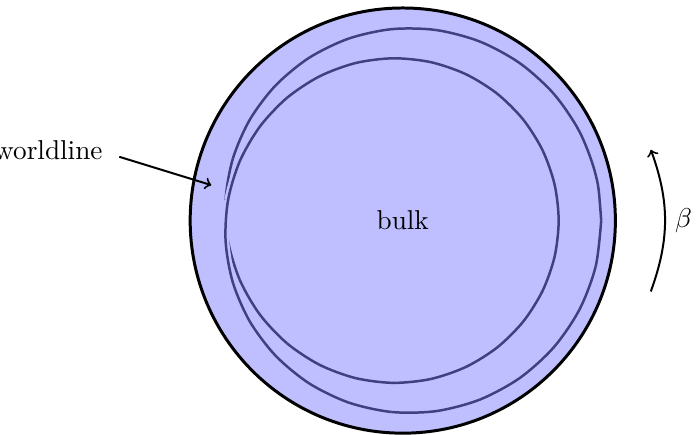
Figure 6 . We fill the boundary thermal circle with a bulk spacetime. On this bulk spacetime, we let free particles propagate. In the picture, the worldline represents the second covering space of figure